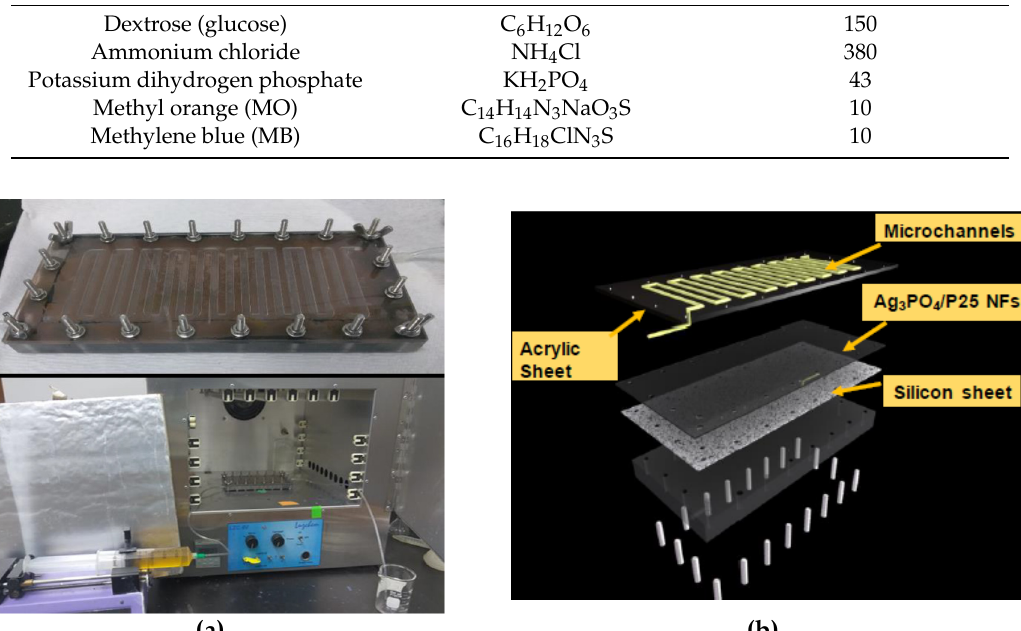
Figure 9. Pictorial view of Luzchem photoreactor ( a ) and lab-scale plug flow reactor ( b ). Table 2. Composition of pretreated simulated textile effluent.